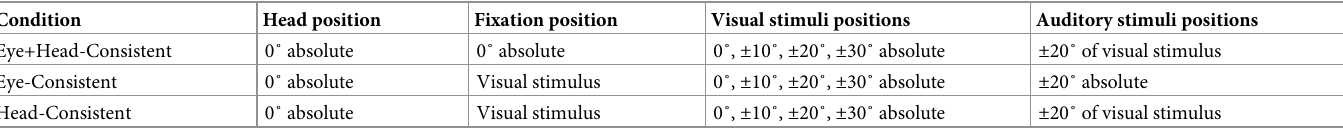
Table 1. Experiment 1: Summary of head, fixation, and stimulus positions for each adaptation